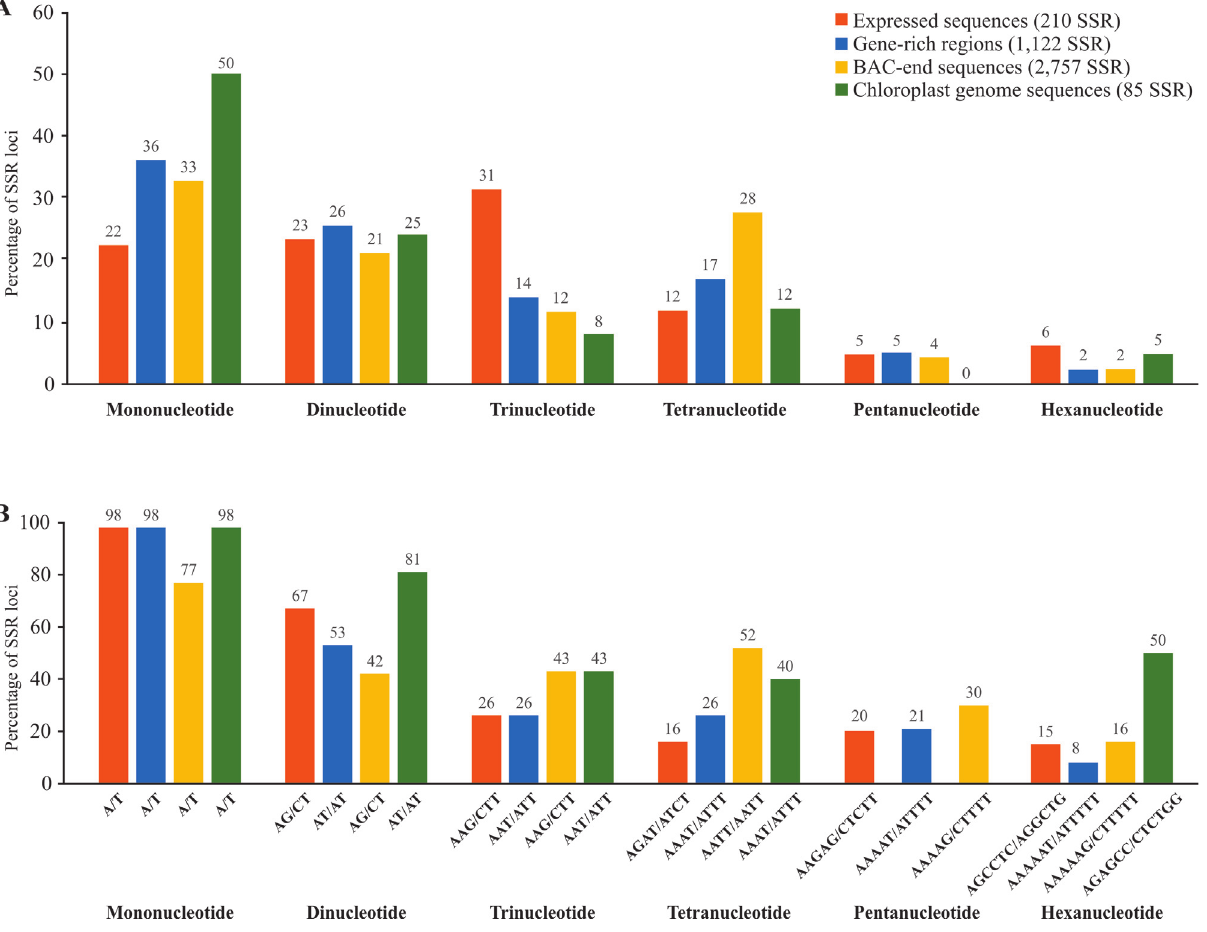
Figure 1 - The percentage of mono-, di-, tri-, tetra-, penta- and hexanucleotides in the microsatellites found in expressed sequences, gene-rich regions, BAC-end sequences and in the chloroplast genome of Passiflora edulis (Passifloraceae) (A); the percentage of the most common motif is displayed for each case